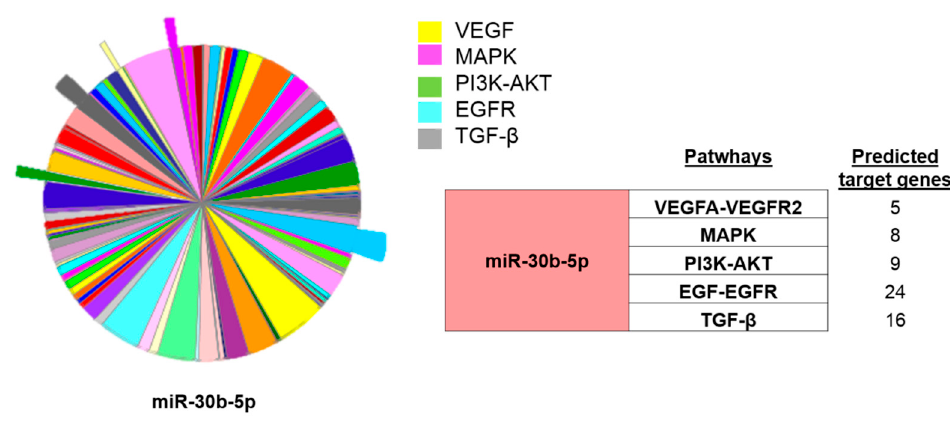
Figure 8. In silico analysis of miR-30-b targets. PANTHER analysis showing the miR-30b-5p predicted target genes involved in different pathways involved in vascular remodeling. The table on the left indicates numbers of miR30b-5p predicted target genes of each signaling pathway. Vascular Endothelial Growth Factor and its Receptor (VEGF-VEGFR), Mitogen-Activated Protein Kinases (MAPK), Phosphatidylinositol 3-Kinase (PI3K-AKT), Endothelial Grow Factor and its receptor (EGR-EGFR) and Transforming Growth Factor